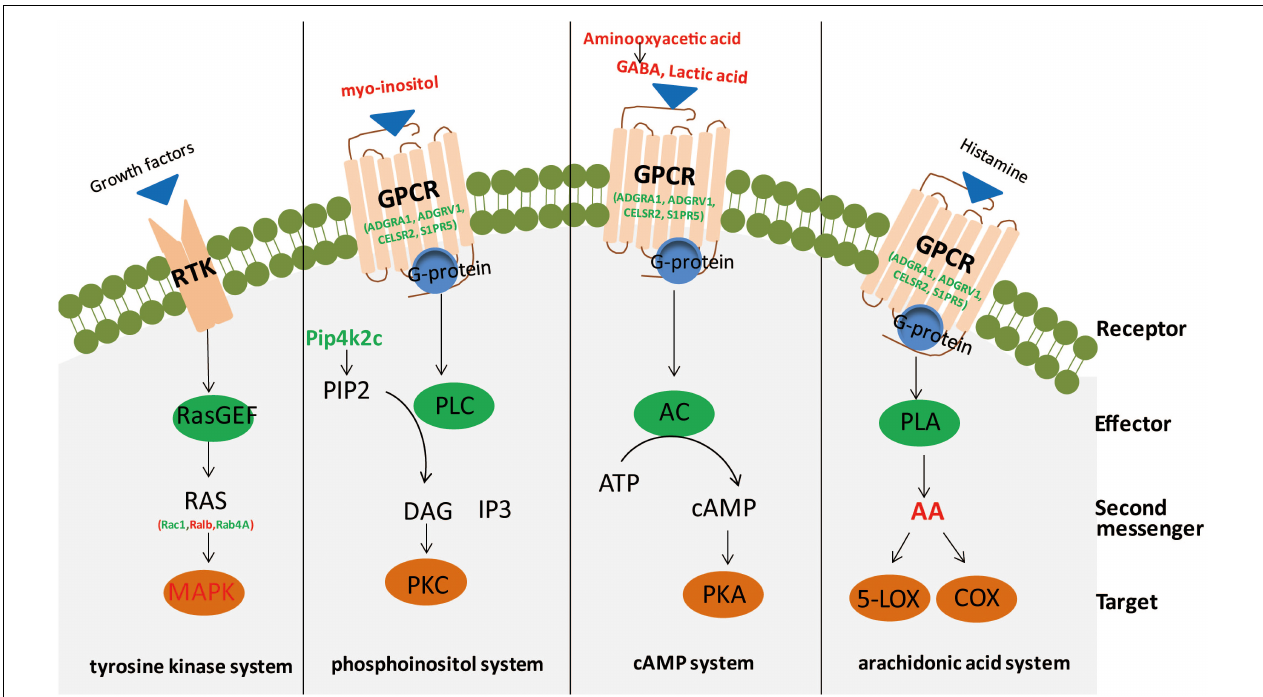
FIGURE 5 | Second messengers disseminate information received from cell-surface receptors. A simplistic diagram of second messenger systems, including tyrosine kinase, phosphoinositol, cyclic adenosine monophosphate (cAMP), and arachidonic acid (AA) systems. In the tyrosine kinase system, binding of growth factors to a receptor tyrosine kinase (RTK; the receptor) can activate RasGEF (the effector) to produce RAS (the second messenger) to activate mitogen-activated protein kinase (MAPK; the target). For the phosphoinositol system, binding of ligands to a GPCR (receptor) activates phospholipase C (PLC; effector), to generate 2 s messengers, DAG and IP3, which activate protein kinase C (PKC; target) and release calcium from intracellular stores. Red, significantly increased; green, significantly decreased. In the cAMP system, binding of agonists to a GPCR (receptor) can activate adenylyl cyclase (AC; effector) to produce cAMP (second messenger) to activate protein kinase A (PKA; target). In the AA system, binding of ligands to a GPCR (receptor) can activate phospholipase A (PLA; effector) to generate AA (second messenger), which activates targets cyclooxygenase (COX) or 5-lipoxygenase